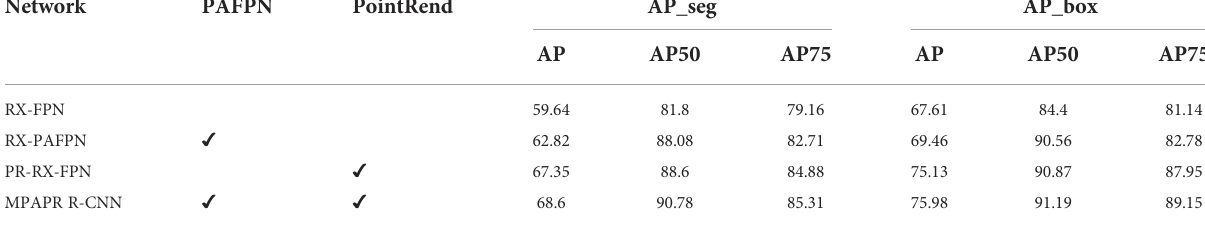
TABLE 3 Comparison of AP results for four different methods.